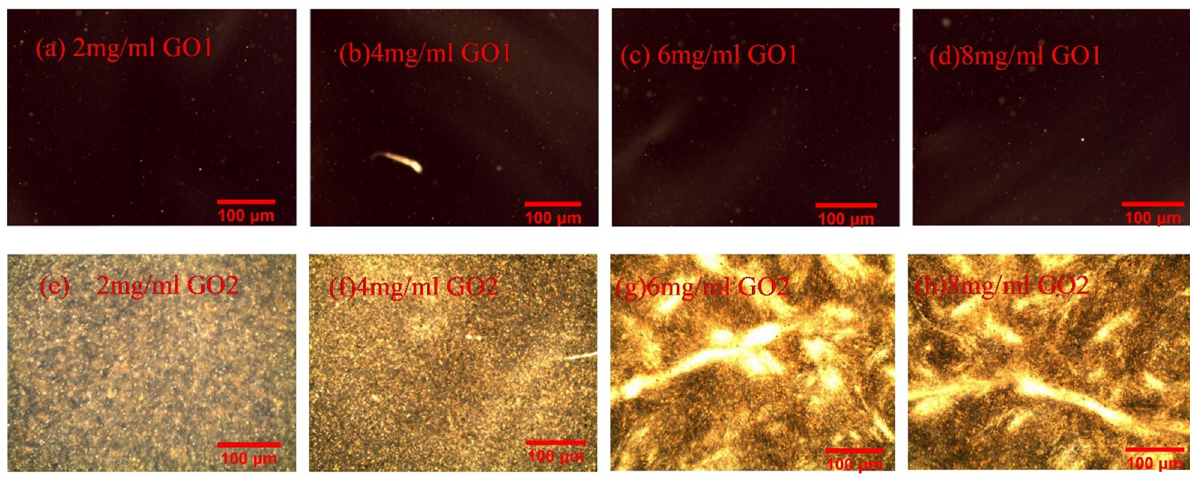
Figure 4: The orthogonal polarization photos of GO1/DMSO solution ( a – d ) and GO2/DMSO solution ( e – h )